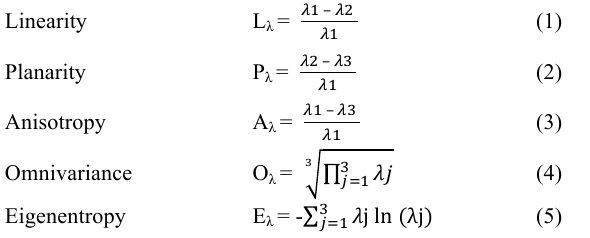
Table 1: The mathematic formulation of some